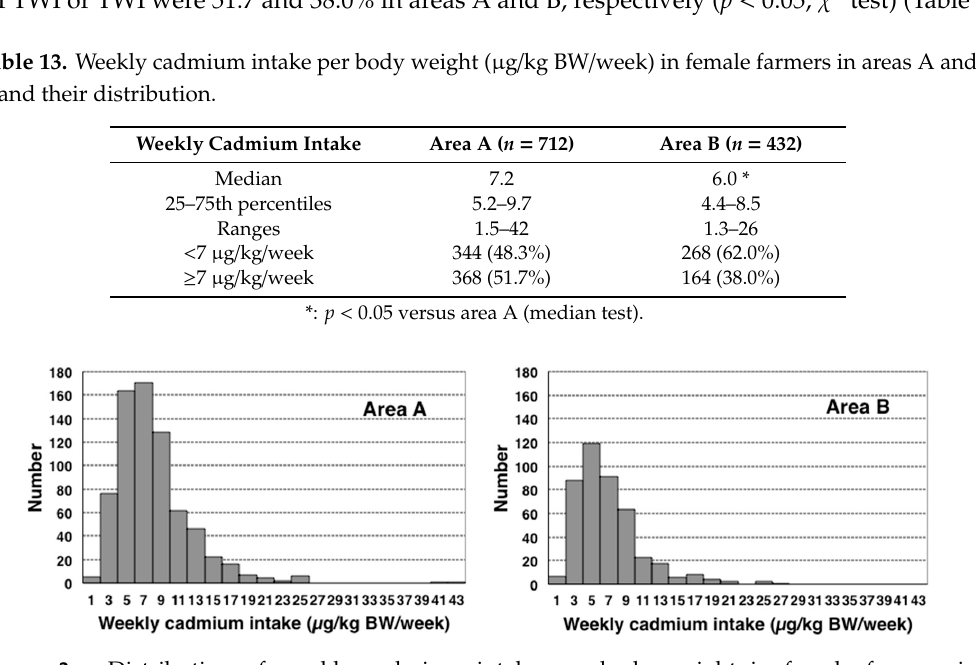
Figure 3. Distribution of weekly cadmium intake per body weight in female farmers in cadmium-polluted areas A and B in Akita, Japan.